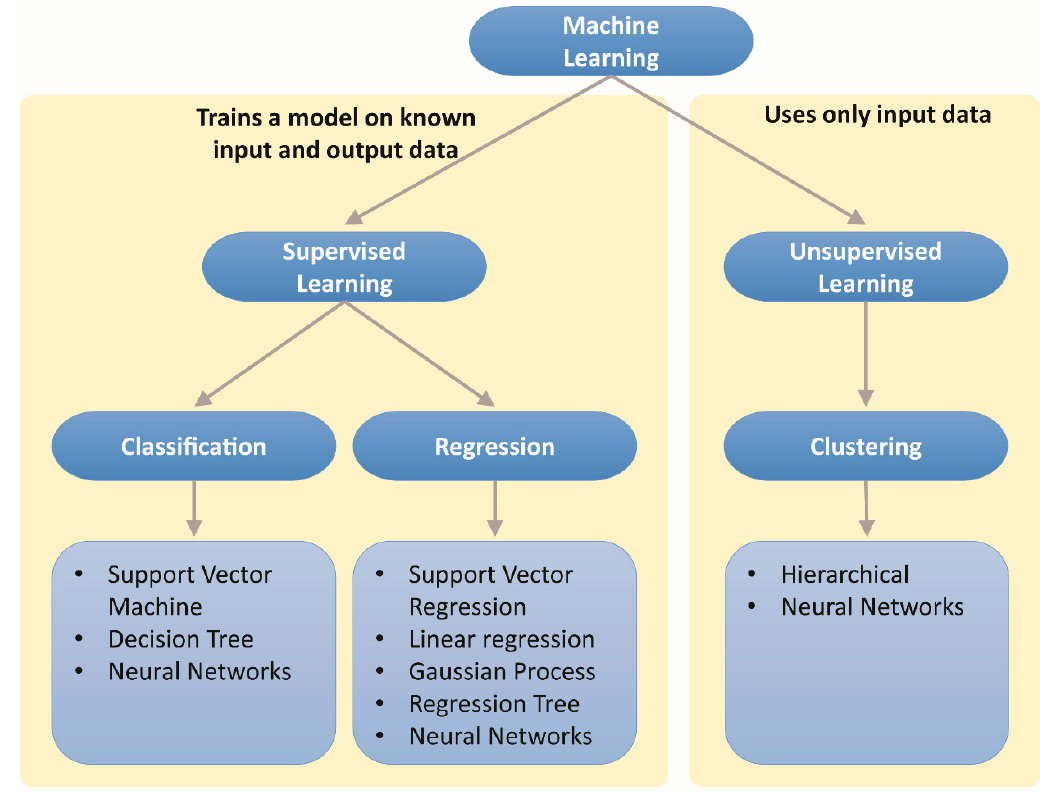
Figure 6. Classification of typical machine learning pr ocess.